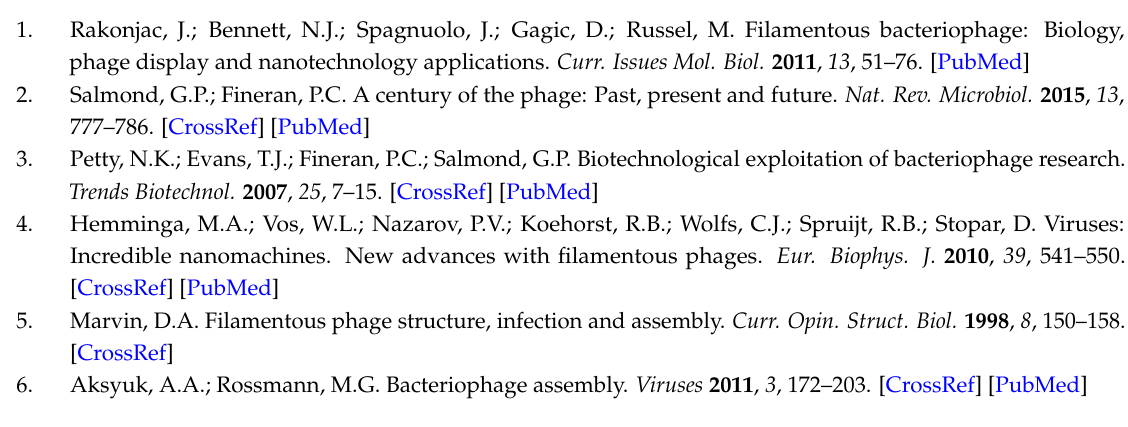
Figure S1: Alignment of filamentous phage gp1 proteins, Figure S2: Alignment of filamentous phage gp1 Walker A and Walker B motifs, Figure S3: Conserved Glycine and Cysteine residues in the alignment of filamentous phage gp1 proteins. Figure S4: Protein expression test of His-tagged gp1 mutants and